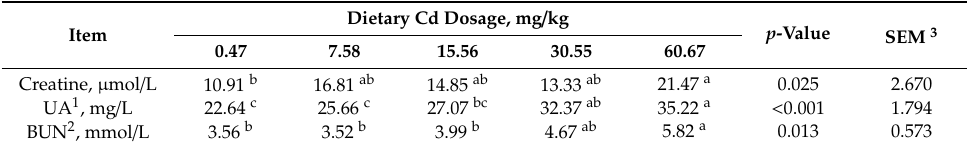
Table 2. E ff ects of Cd on serum biochemical of renal function in laying Table 2. Effects of Cd on serum biochemical of renal function in laying hens.